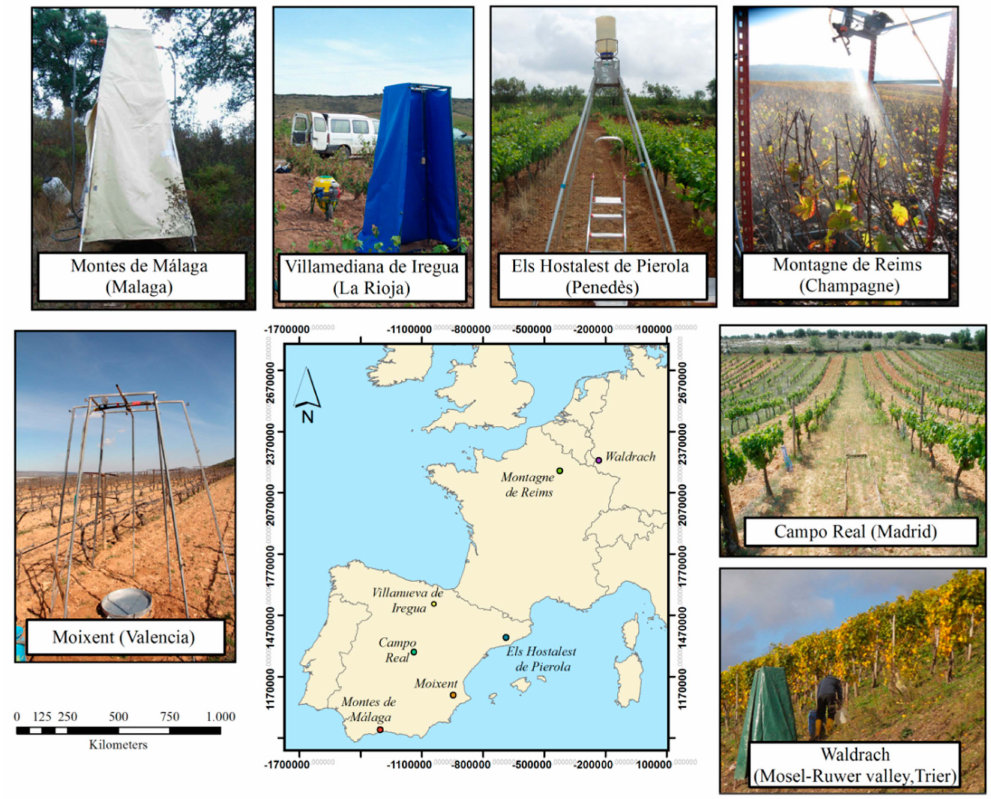
Figure 1. Localization of the study